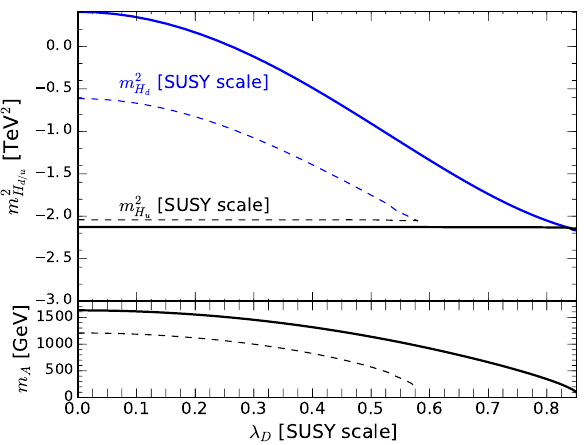
Figure 4. Soft SUSY-breaking masses m 2 Higgs pole mass m A as a function of the Yukawa coupling (cid:21) D at the SUSY scale. We (cid:12)x m 0 = 300 GeV and m 1 = 2 = 1500 GeV. We assume tan (cid:12) = 10 for the thick solid lines and tan (cid:12) = 40 for the thin dashed